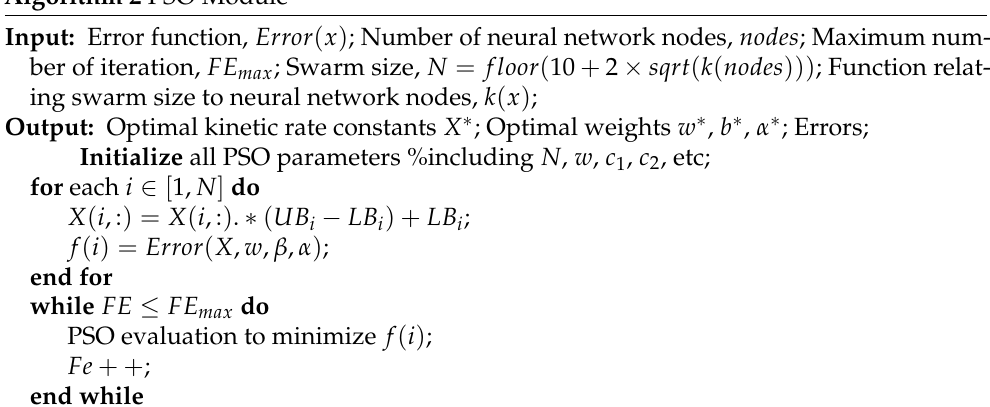
Algorithm 2 PSO Module